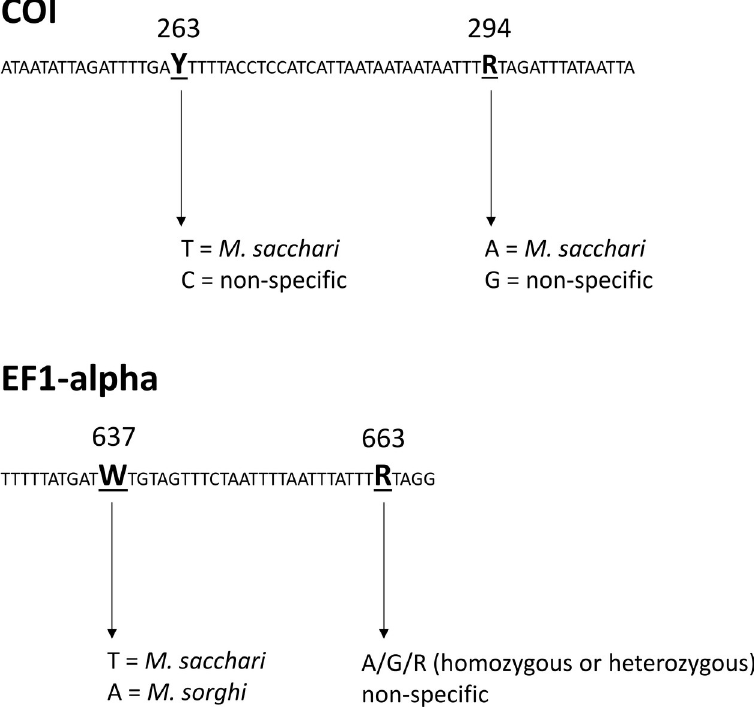
Fig 7. Molecular diagnosis for separation of M . sacchari and M . sorghi using sequencing of COI or EF1- α .